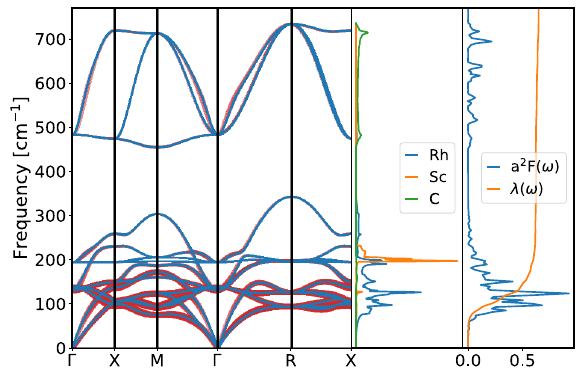
Fig. 5 Calculated phonon dispersion curves (left), projected phonon density-of-states (center), α 2 F ( ω ) and λ ( ω ) (right) for ScCRh 3 . The red circles represent the phonon linewidths with radius proportional to the respective electron – phonon coupling strength.